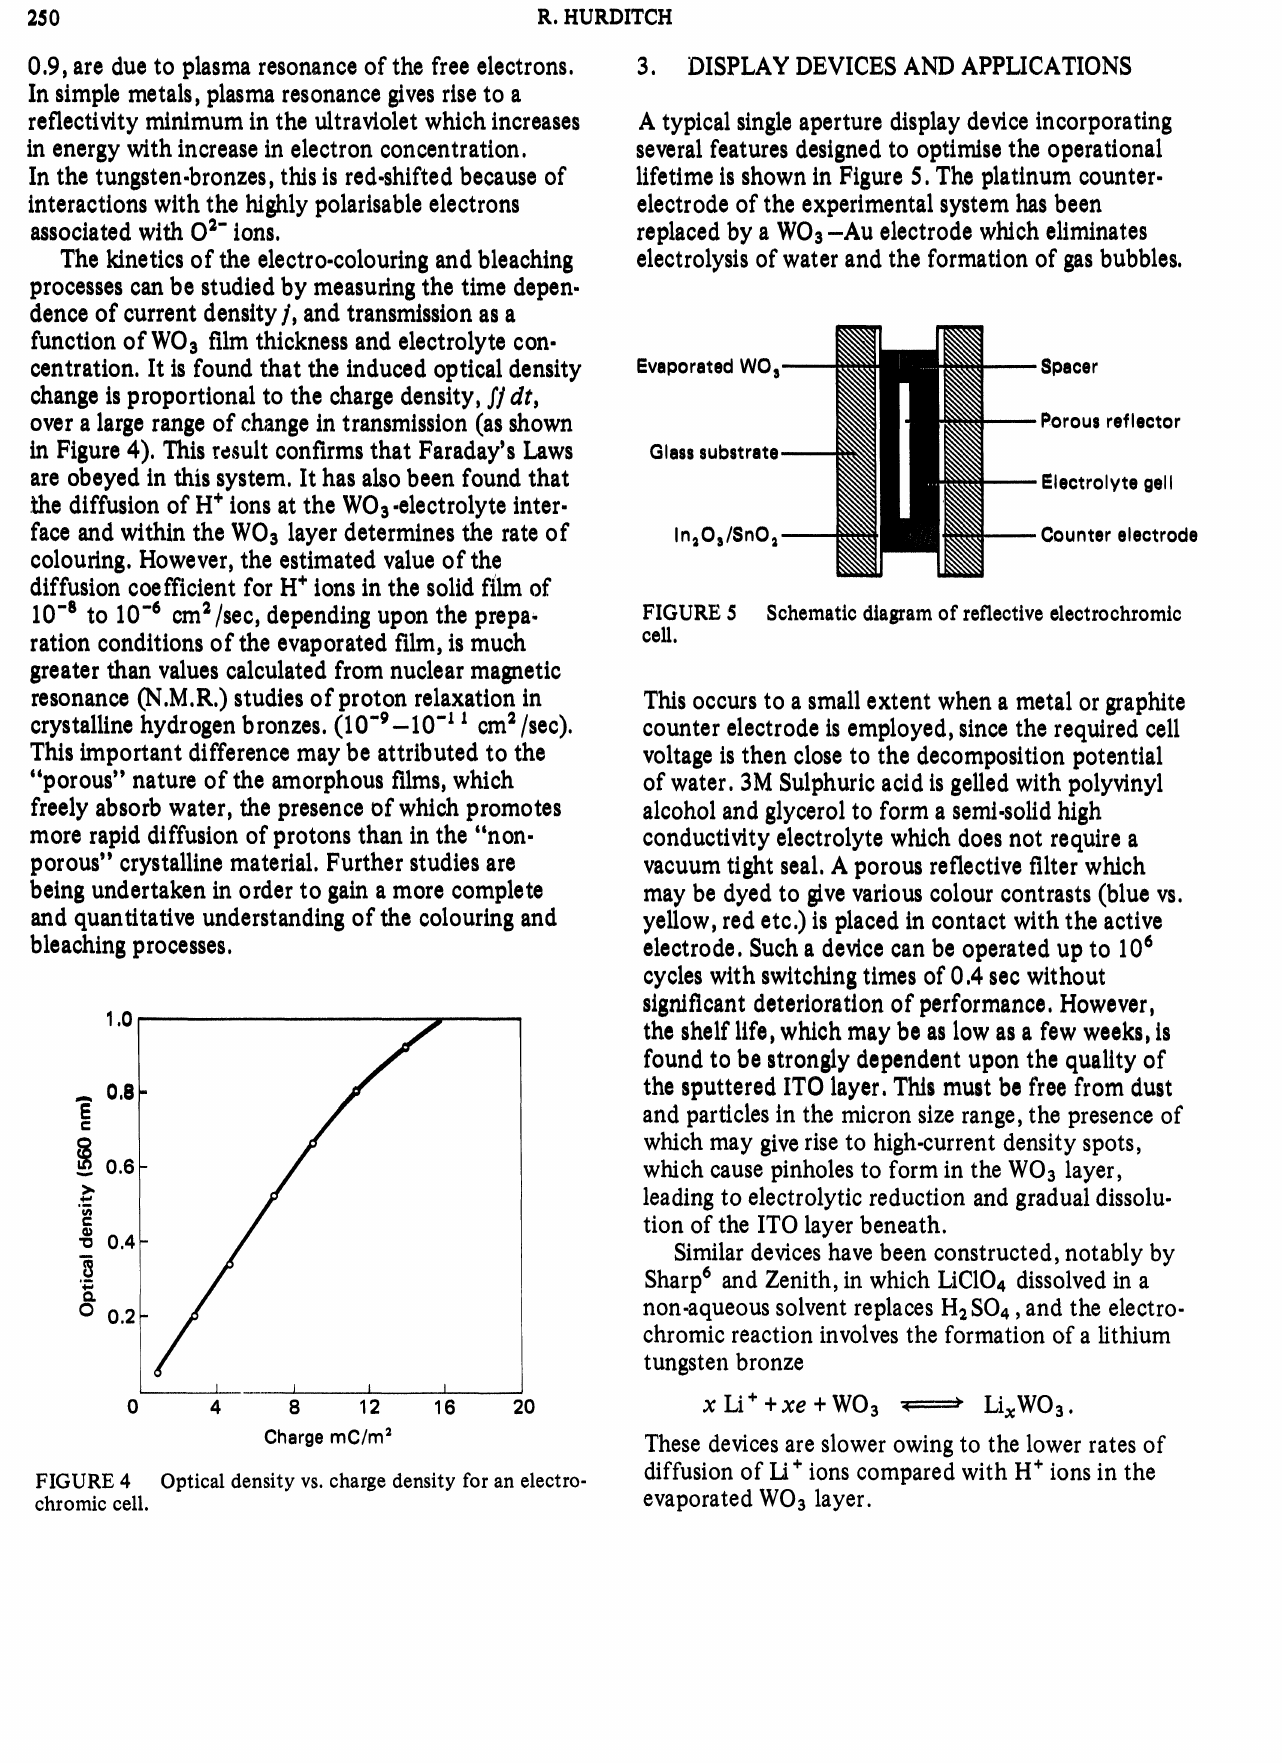
Optical density vs. charge density for an electro- chromic cell.